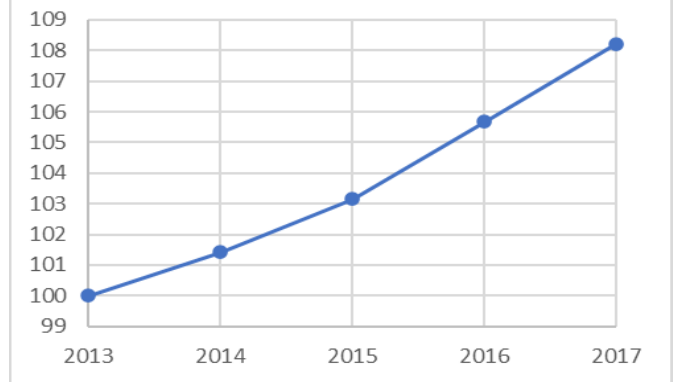
Figure 13. GDP growth in percentage w.r.t. to the 2013 value.